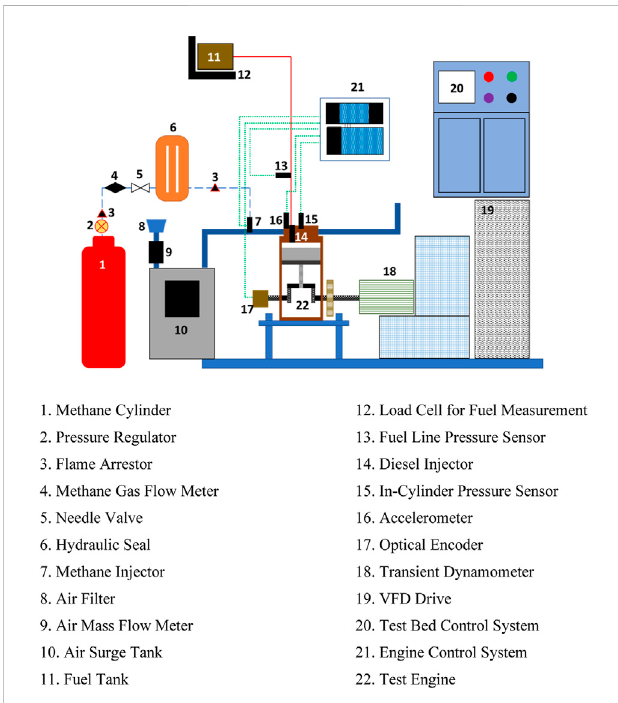
FIGURE 1 Schematic for the methane diesel dual fuel engine test